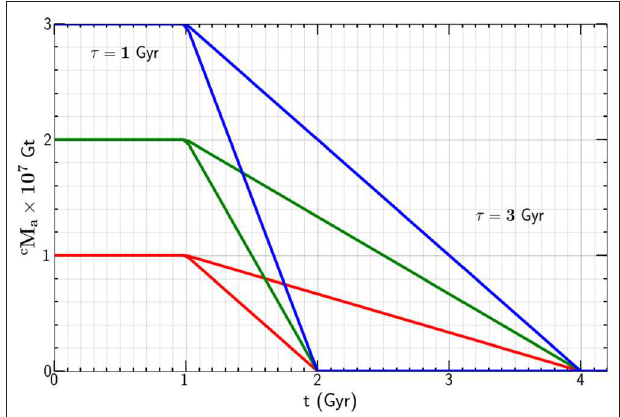
FIGURE 2 | Dependence of the mass of carbon in the atmosphere c M a on time t for t 0 = 1 Gyr, τ = 1and 3 Gyr, and c M a 0 = 1,2,3 × 10 7